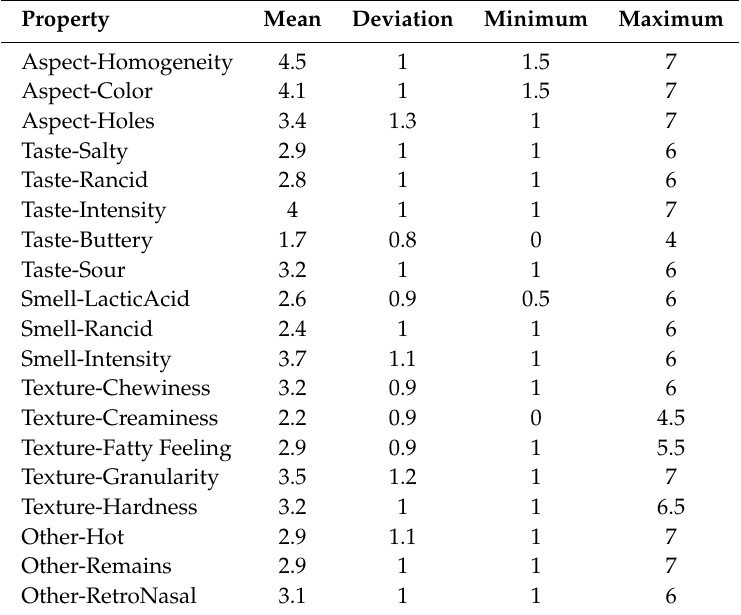
Table 1. Sensory parameters applied by the taster panel and their main statistical descriptions for the total sample dataset considering judges’ individual